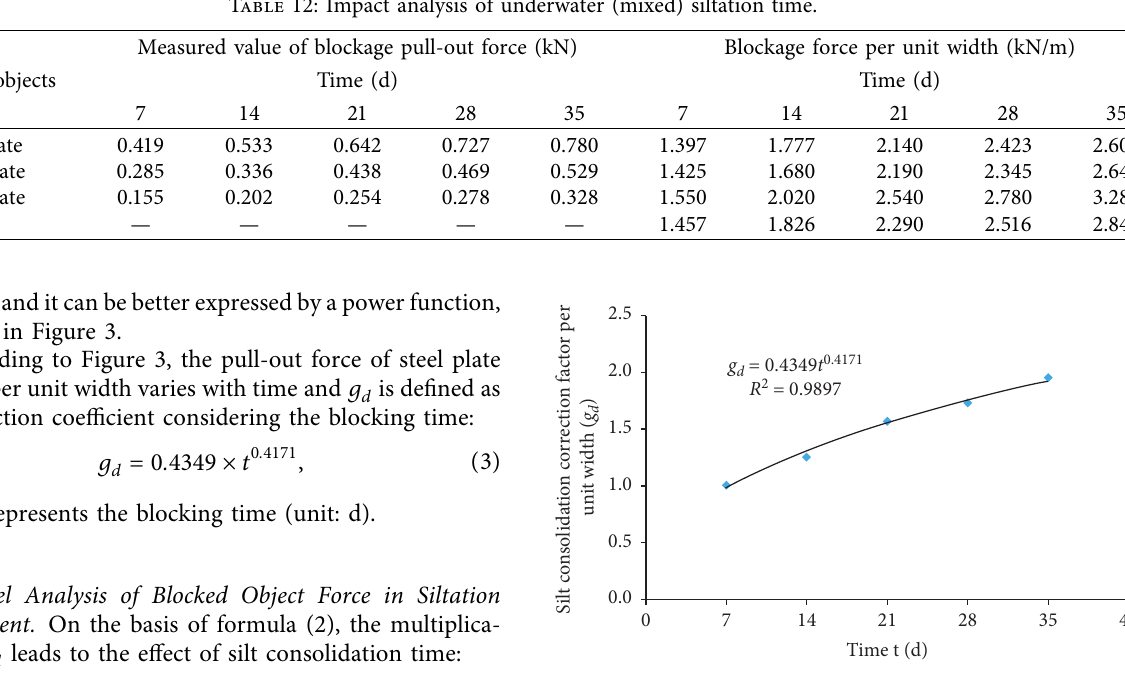
Figure 3: The pull-out force (normalized) of steel plate deposits per unit width varies with